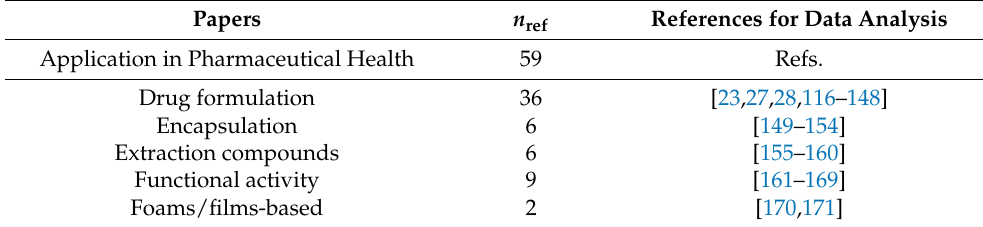
Table 4. Application of mixture design in pharmaceutical